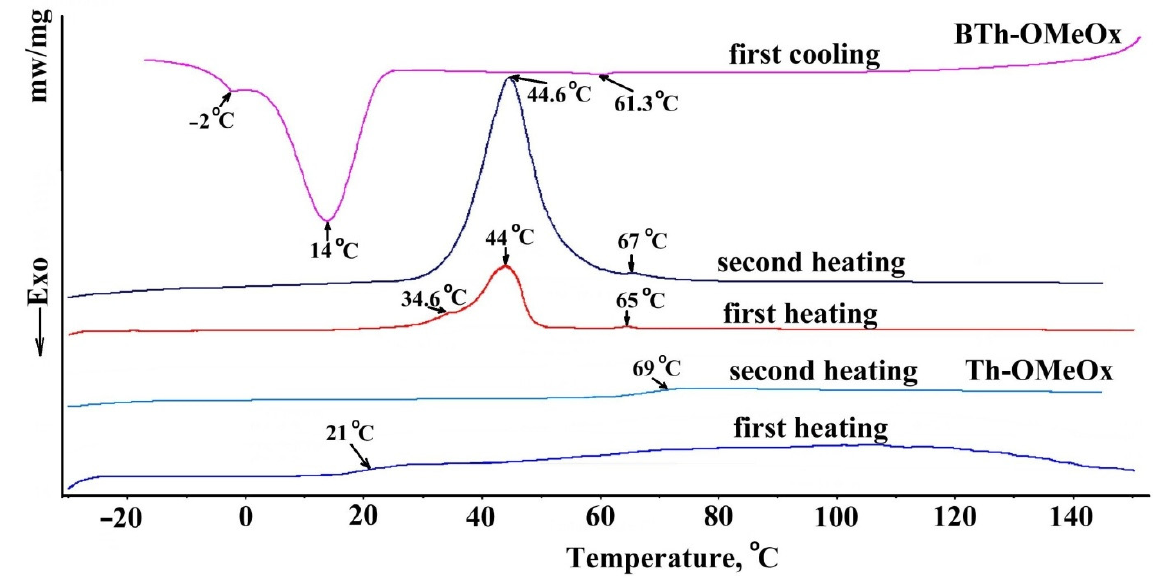
Figure 6. DSC traces of Th-OMeOx and of BTh-OMeOx .